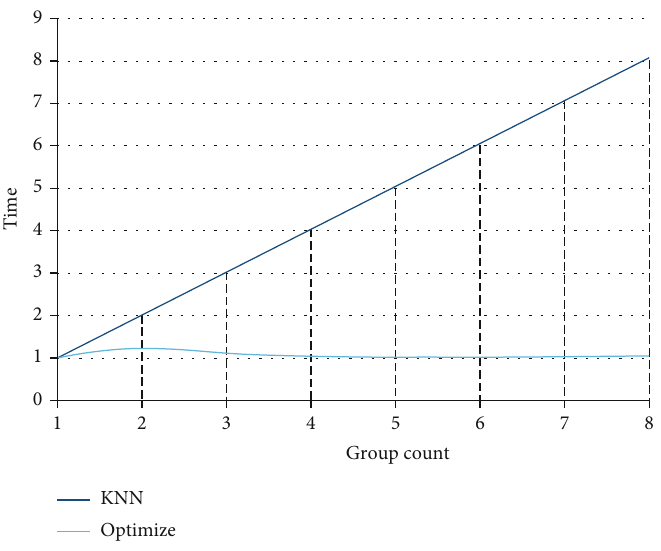
Figure 1: Average recommended consumption time comparison.